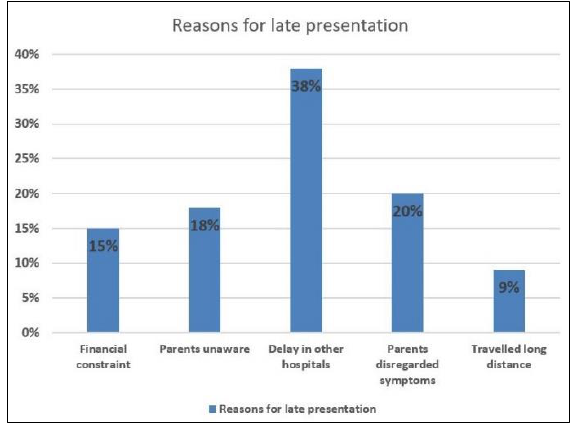
Figure 1: Reasons for late presentation